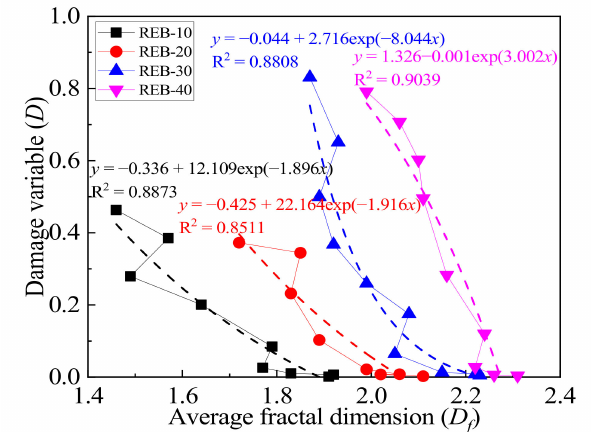
Figure 17. The relationship between the damage variable and the average fractal